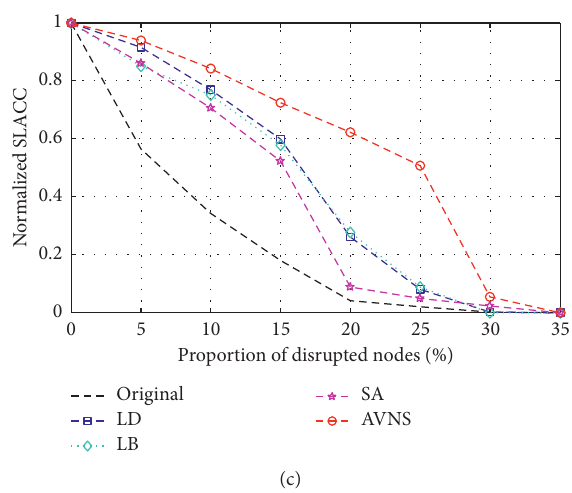
Figure 11: Response of chain 25 and reconfigured ones facing random disruptions. (a) f